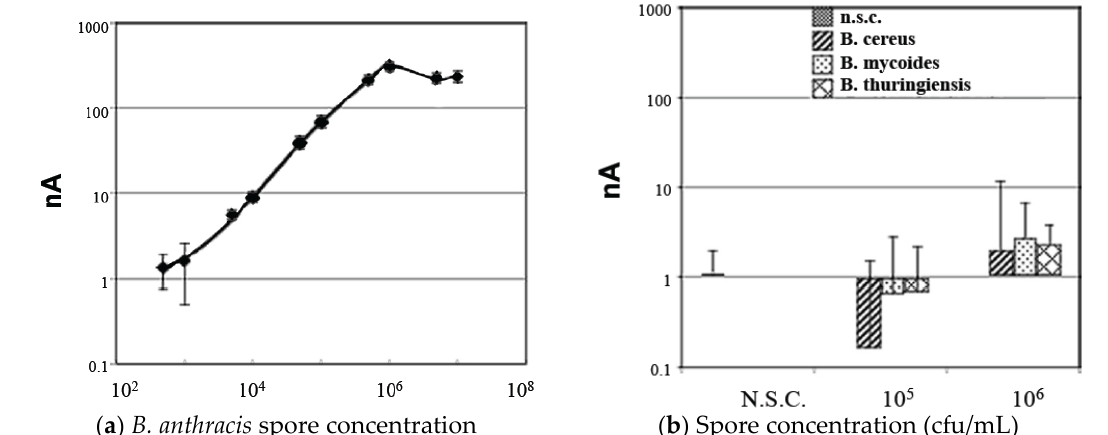
Figure 2. ( a ) Standard curve for detection of pure B. anthracis spore suspensions (spores serially diluted in 0.1% Tween 20). Each data point represents at least 10 blindly tested sample replicates. Error bars = +/− standard deviation (SD). ( b ) Negative control samples including no spore controls (0.1% Tween 20 without spores) and spores of other Bacillus species tested in the assay at the indicated concentrations